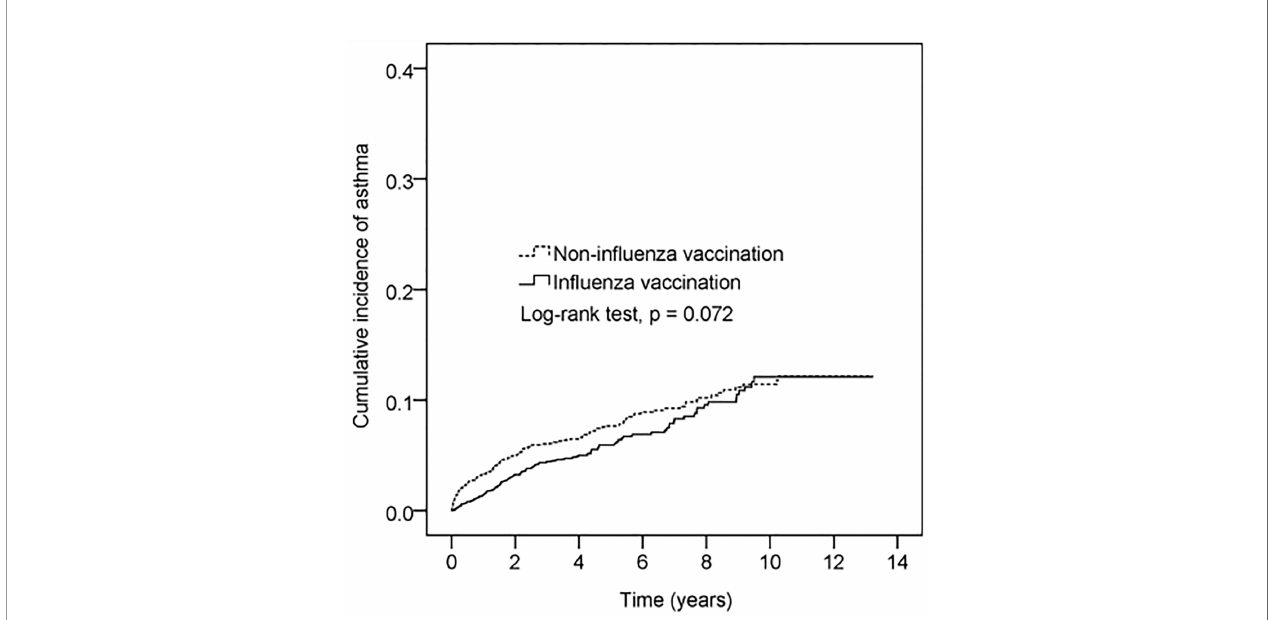
FIGURE 2 | Cumulative incidence of asthma in patients with vaccination vs without vaccination. The x-axis represents years after fl u vaccination. The index date of the unvaccinated group was assigned by 1:1 age and sex matching. Y-axis represents cumulative incidence of